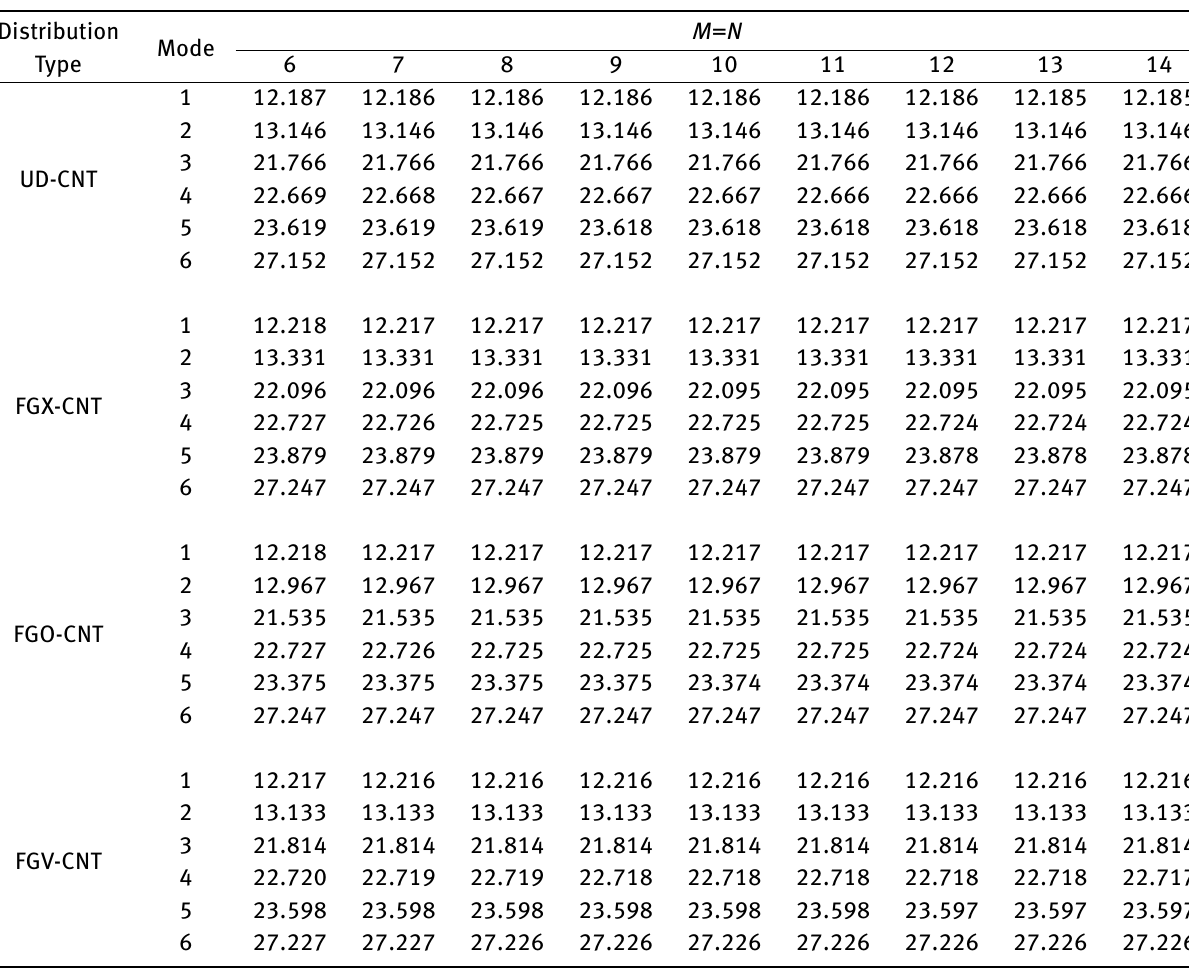
Table 2: Convergence of the frequency parameters Ω for a FG-CNT reinforced composite annular sector plate with CSDCSD boundary condi- tion